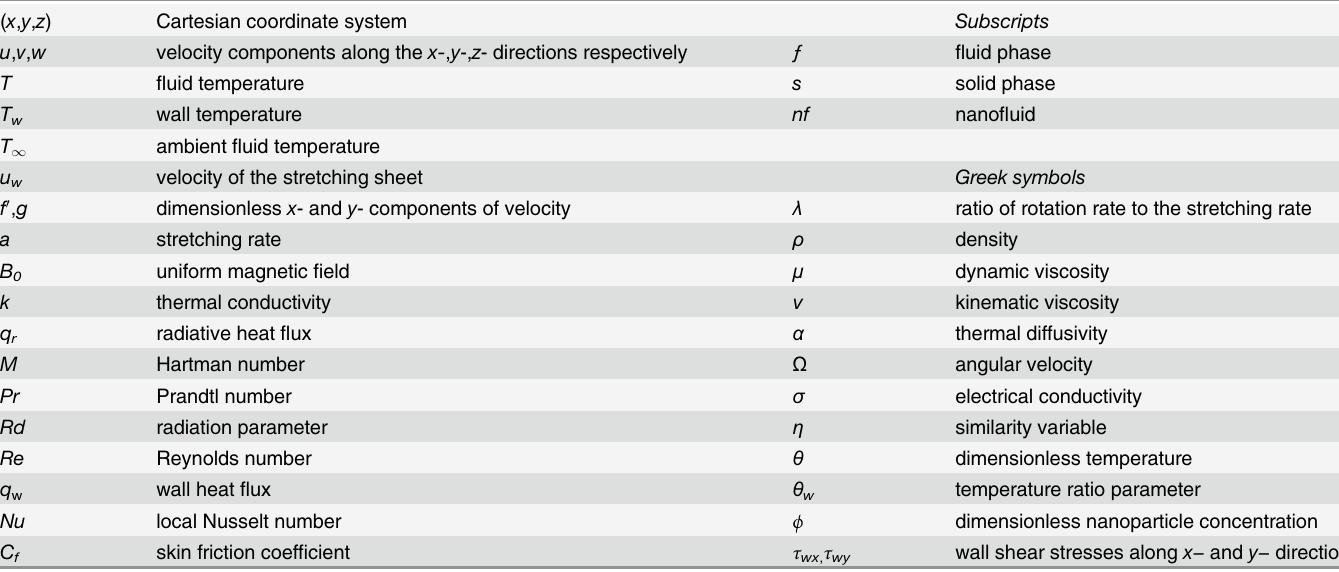
Table 1. List of